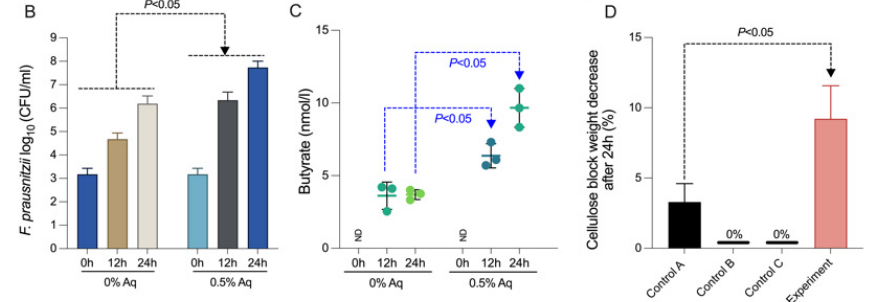
Figure 3. F. prausnitzii in vitro growth, butyrate production and substrate digestion. Panel ( A )—experimental design (Created with Biorender.com), Panel ( B )— F. prausnitzii growth, Panel ( C )—butyrate production, Panel ( D )—Cellulose degradation. All experiments were performed in triplicate. A p value of less than 0.05 was considered as significant.